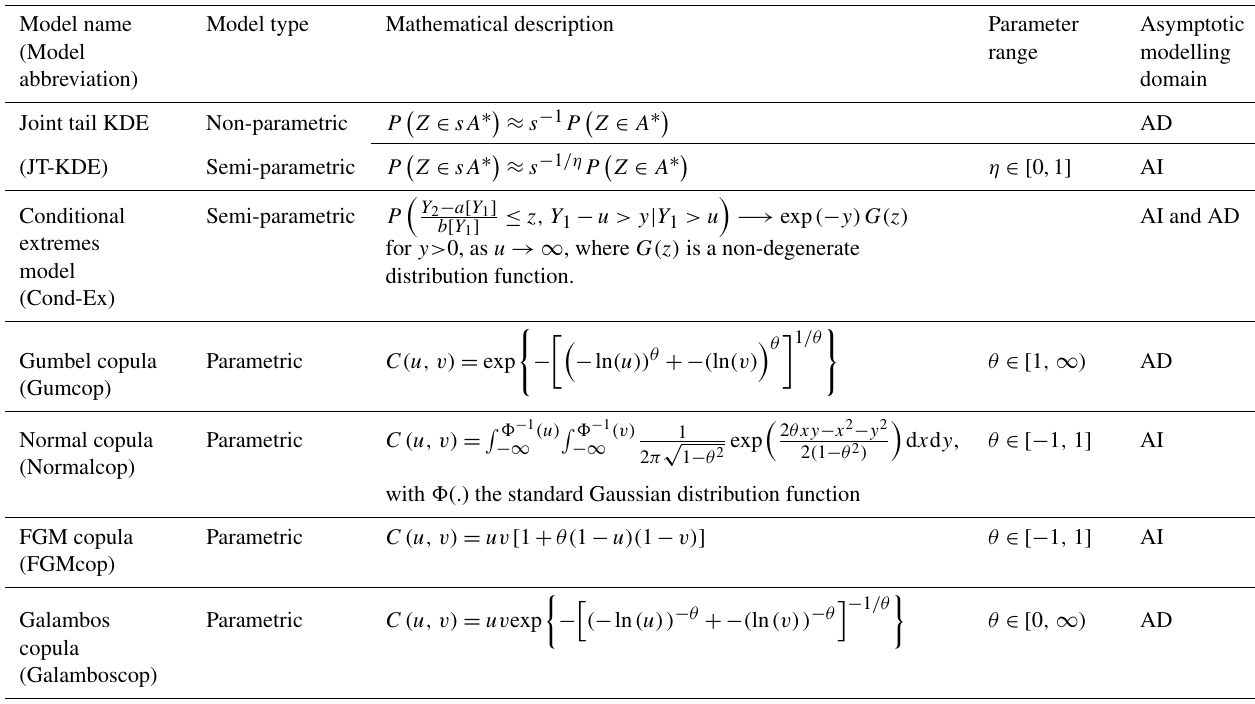
Table 2. Description of the six statistical models compared in this article. The description includes the model name and abbreviation (used throughout the article), type of model (parametric, semi-parametric, non-parametric), the mathematical description, the parameter range (where relevant) and the asymptotic modelling domain (AI for asymptotic independence and AD for asymptotic